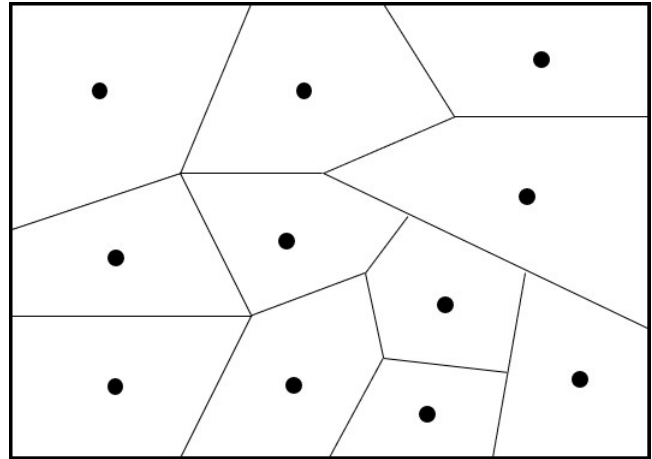
Figure 1. Conventional Voronoi diagram.